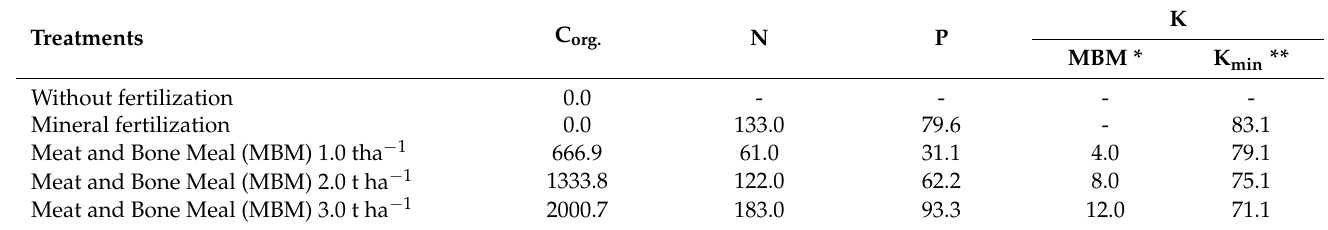
Table 2. Design of the field experiment. The amount of macronutrients introduced to soil with fertilizers (mean of 2014–2017, kg ha − 1